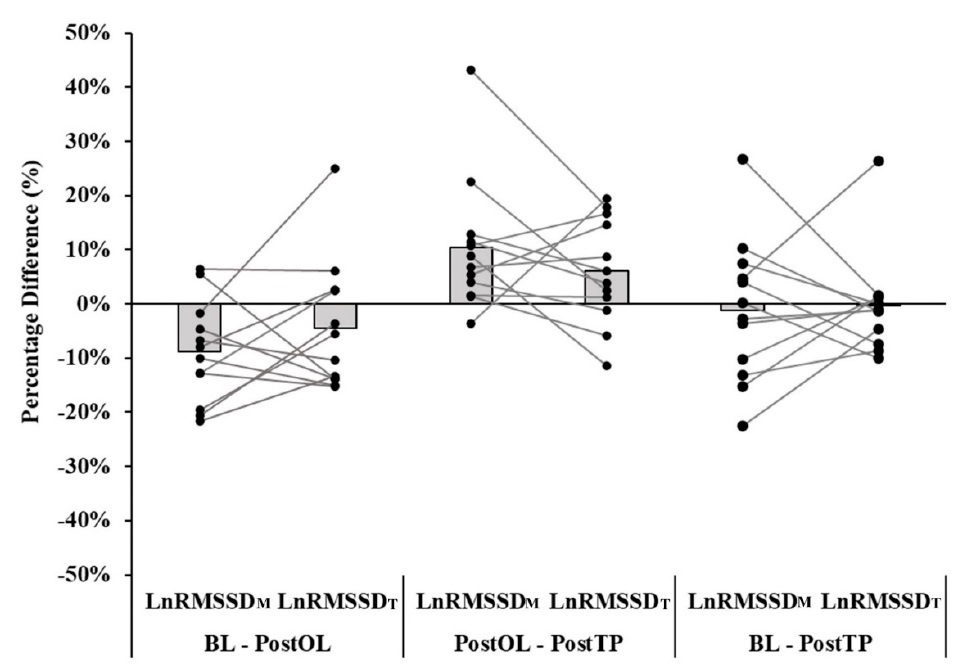
Figure 1. Individual changes in the natural logarithm of root mean square of successive R–R interval differences during the morning (LnRMSSD M ) and pre-testing (LnRMSSD T ) time points between baseline (BL), post-overload (PostOL), and post-taper (PostTP) test days.